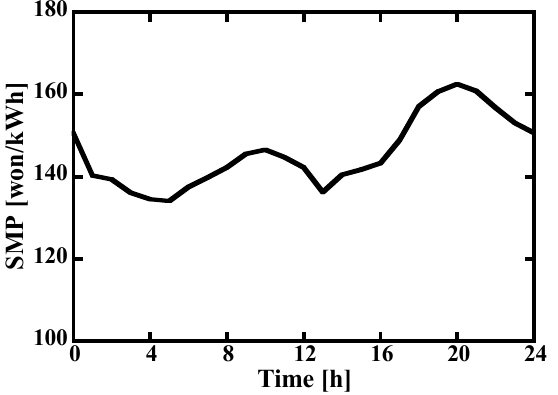
Figure 12. Hourly average SMP in 2018 [75].